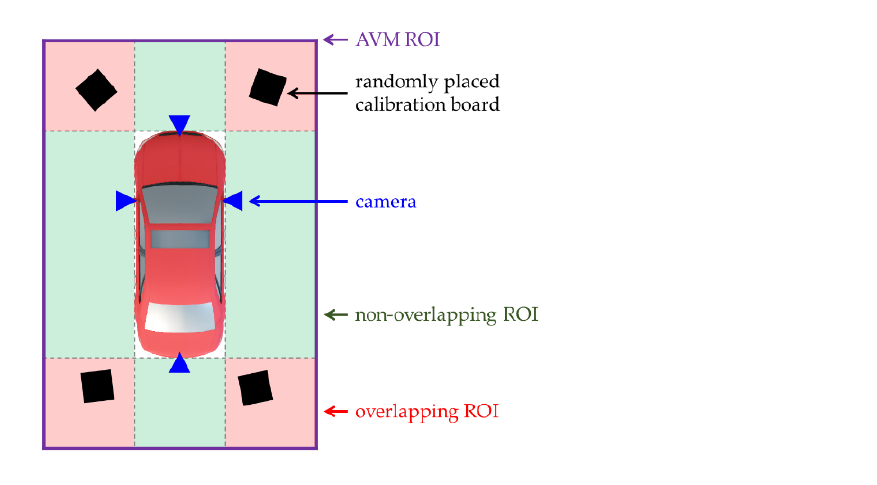
Figure 4. The proposed AVM calibration environment. The region of interest (ROI) of the AVM image (purple rectangle) can be divided into the overlapping ROI (red area) and the nonoverlapping ROI (green area).